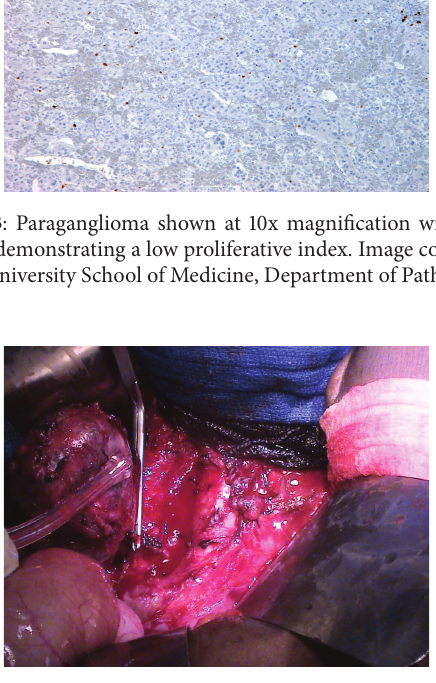
Figure 4: Intraoperative photograph of paraganglioma retracted to revealvascularclampabouttheunderlyinginferiorvenacava.Image courtesy of Tulane University School of Medicine, Department of Endocrine Surgery.